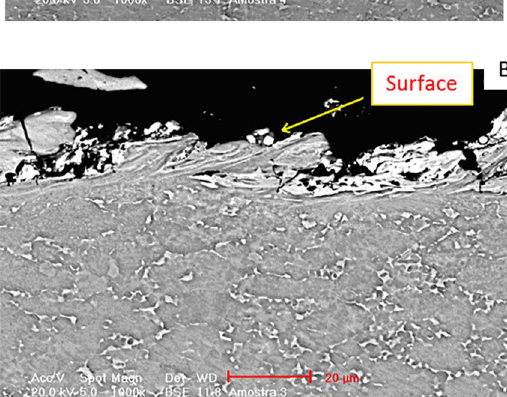
Figure 7. Aspect of the recast layer of the Ti6Al4V alloy machined by the WEDM process with a brass wire, using interval time t (A) 13.2 µs and (B) 23.2